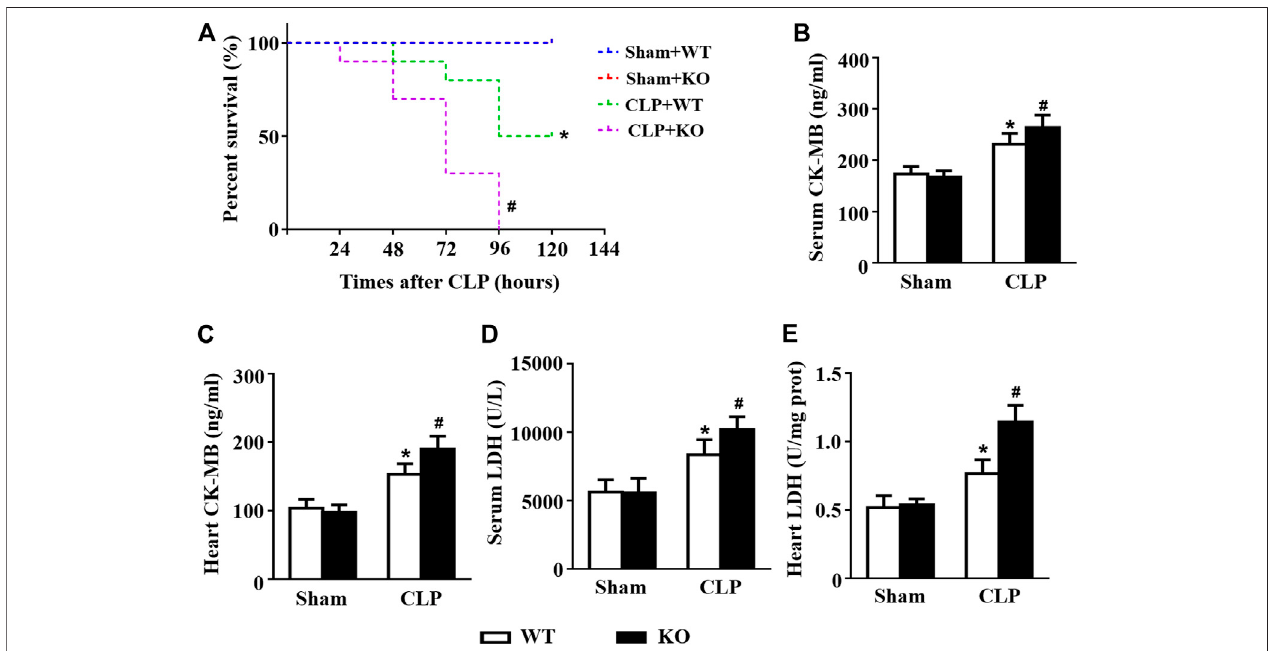
FIGURE 8 | Il12a deletion aggravates CLP-induced cardiac injury. (A) Effect of Il12a de fi ciency on the survival rate after CLP treatment (n (cid:1) 10). (B – C) CK-MB and LDH serum levels were assessed in each group (n (cid:1) 4). (D – E) The cardiac levels of CK-MB and LDH were measured in each group (n (cid:1) 4). * p < 0.05 compared with the sham + WT group; # p < 0.05 compared with the CLP + WT